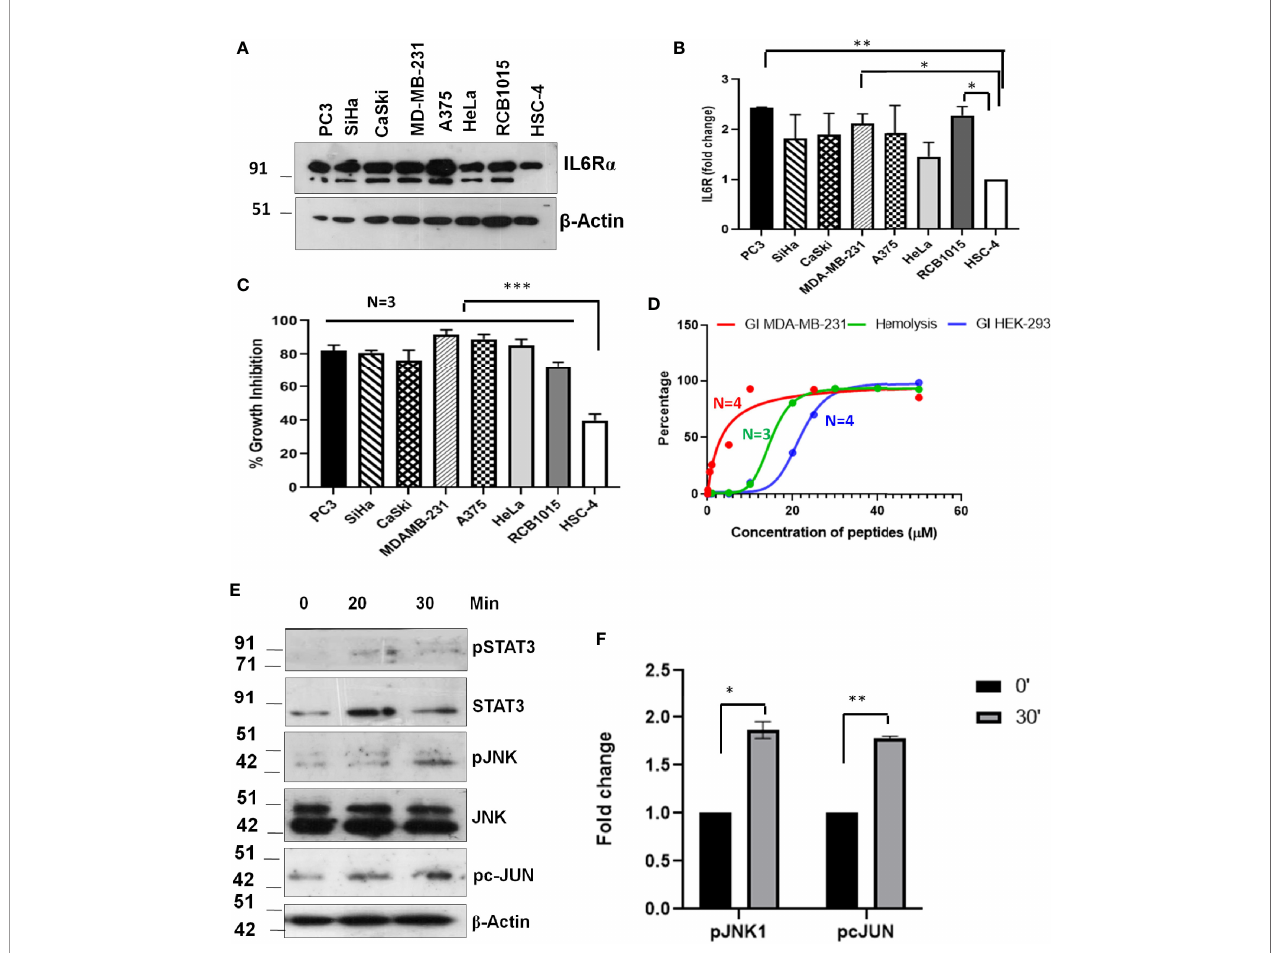
FIGURE 10 | Sensitivity of cancer cells to SSTP1 depends on the level of IL6R a . (A) Western blot performed using cell lysates of different cancer cells. (B) The densitometric analysis of the bands of the blot using ImageJ. (C) Growth inhibition analyzed by MTT assay using 10 m M SSTP1 treated for 48h. (D) Growth inhibitory curve of SSTP1 for MDA-MB-231 cells and HEK-293 cells analyzed after 48h treatment with SSTP1 and Hemolysis induced by SSTP1 on human RBC. The error bars indicate SEM of three biological replicates (E) MDA-MB-231 cells were treated with 4.5 m M SSTP1 for the indicated time intervals and probed for the indicated molecules by western blot. (F) The blots were quanti fi ed using ImageJ, and the graphs were plotted. *p < .05, **p < .01, ***p <